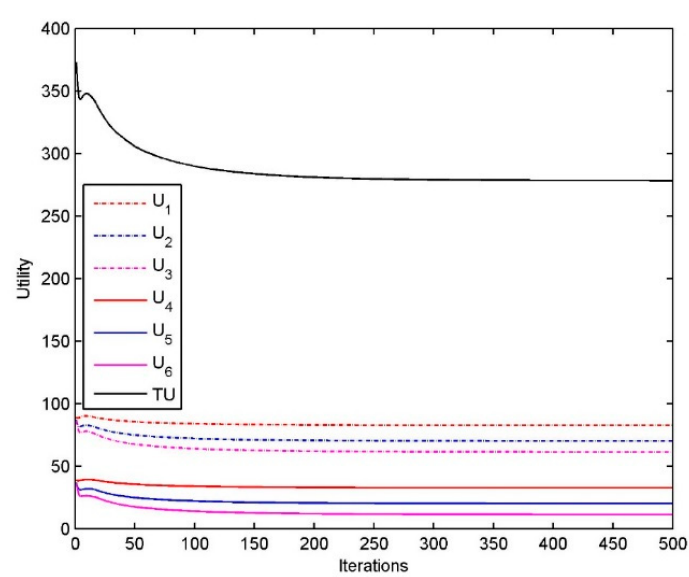
Figure 9. Performance of the resource allocation algorithm for customer 𝑟 : Utility.